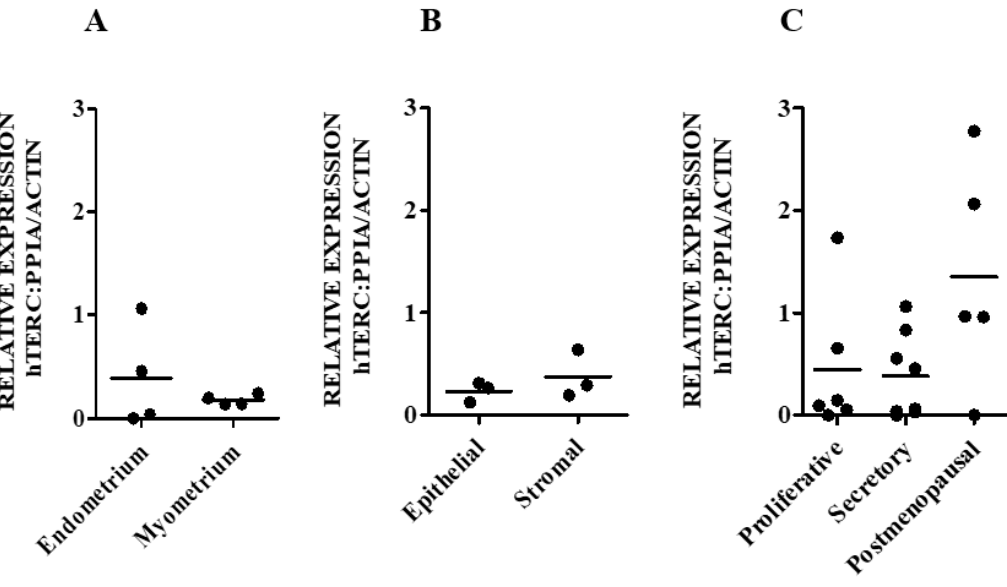
Figure 1. hTERC RNA levels in normal human uterus. hTERC RNA levels were measured using qPCR in the following samples: ( A ) Endometrium (E) ( n = 4) versus myometrium (M) ( n = 4). ( B ) Isolated epithelial (Ep) ( n = 3) versus stromal (St) ( n = 3) endmetrial cells. ( C ) Proliferative (PP) ( n = 6), secretory phase (SP) ( n = 8) and PM ( n = 5) endometrial samples. hTERC expression was normalised to the geometric mean of peptidylprolyl Isomerase A ( PPIA ) and beta-actin ( ACTB ) reference genes.